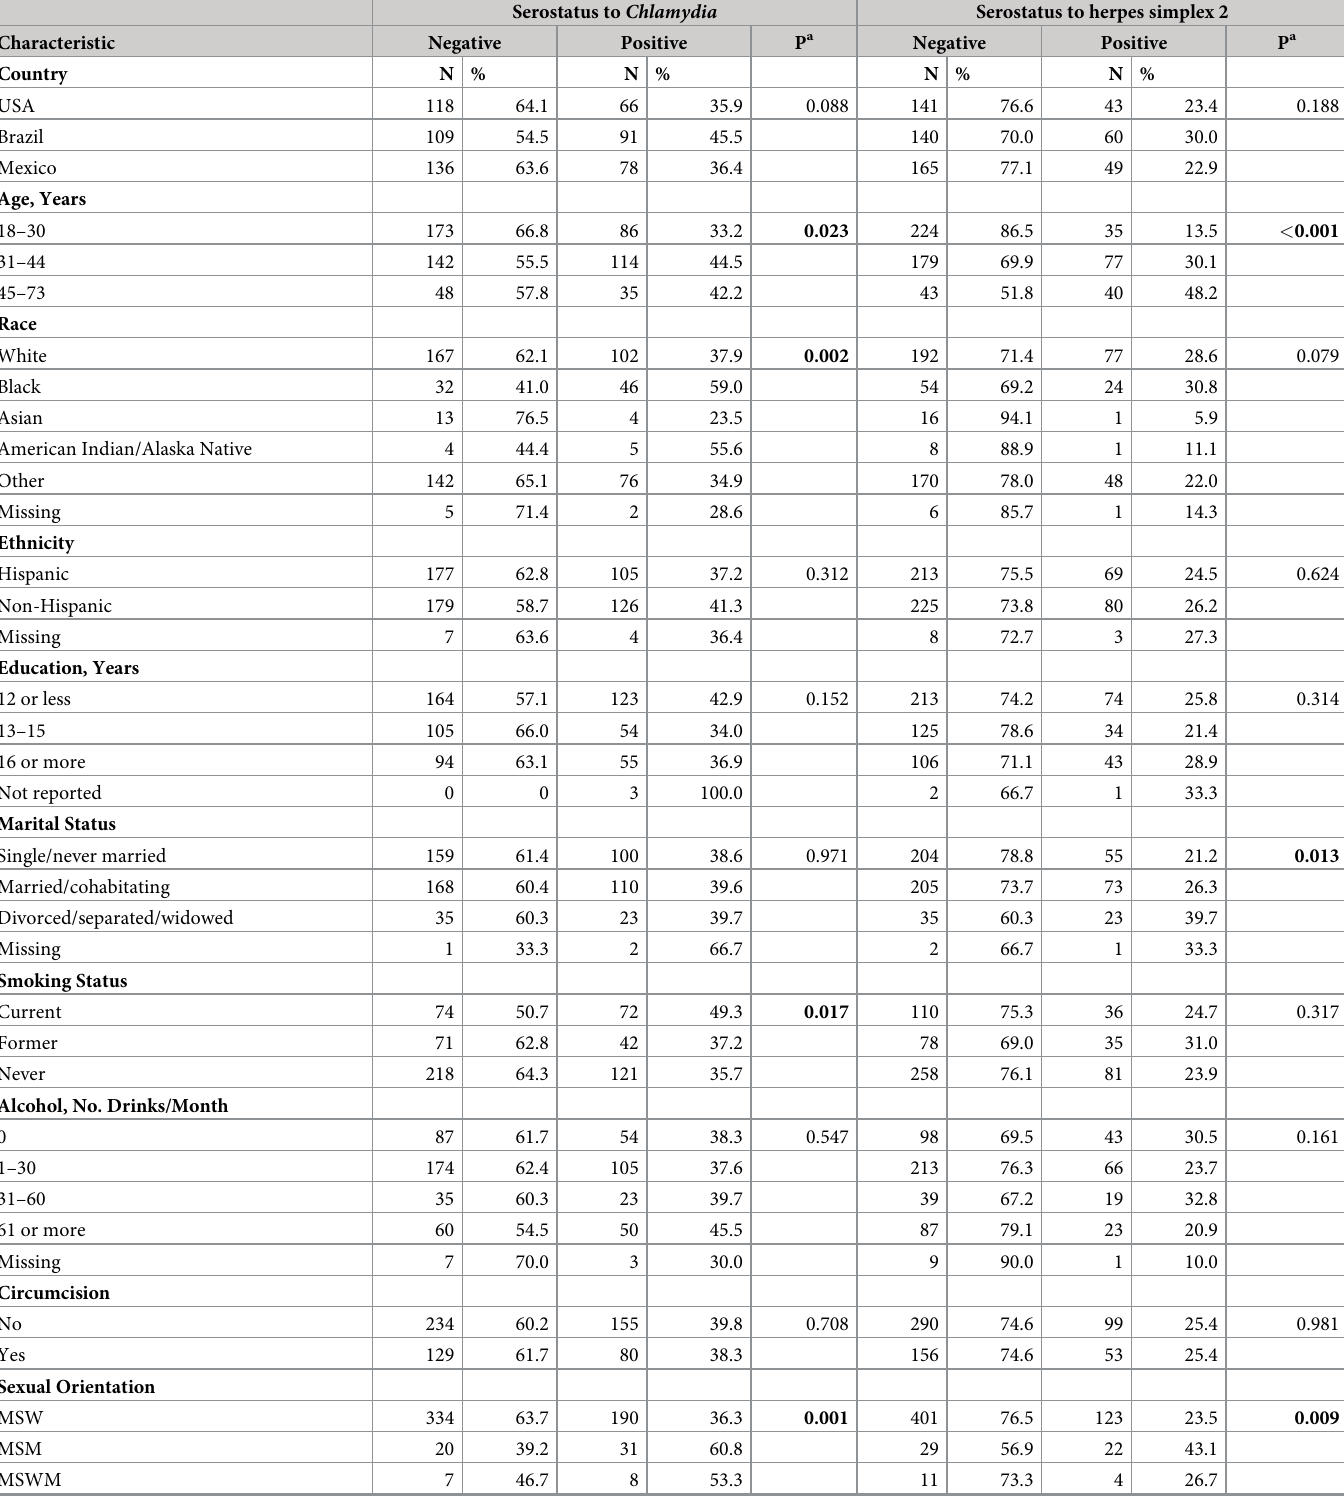
Table 2. Participant characteristics by serostatus to Chlamydia trachomatis and herpes simplex type 2. Serostatus to Chlamydia Serostatus to herpes simplex